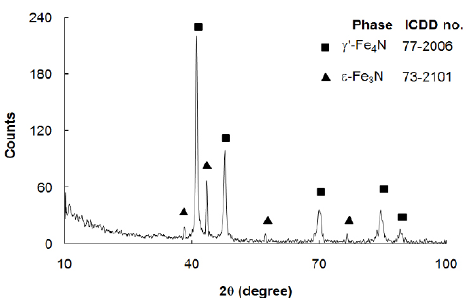
Figure 4. XRD pattern for sample P(12) nitrided with ammonia at 400 o